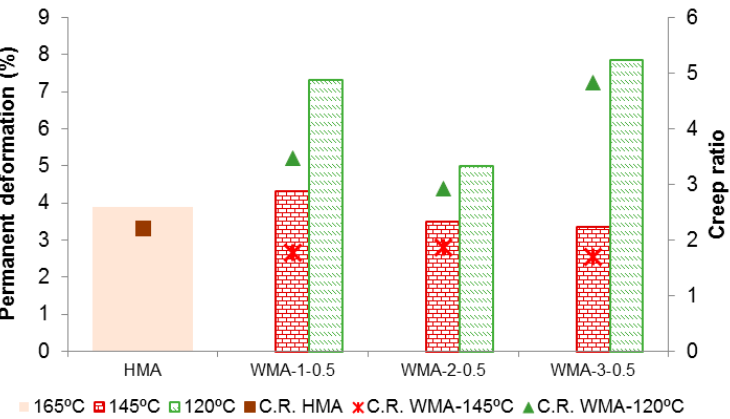
Figure 4. Triaxial results for the Hot Mix Asphalt (HMA) and Warm Mix Asphalt (WMA) with different additives.